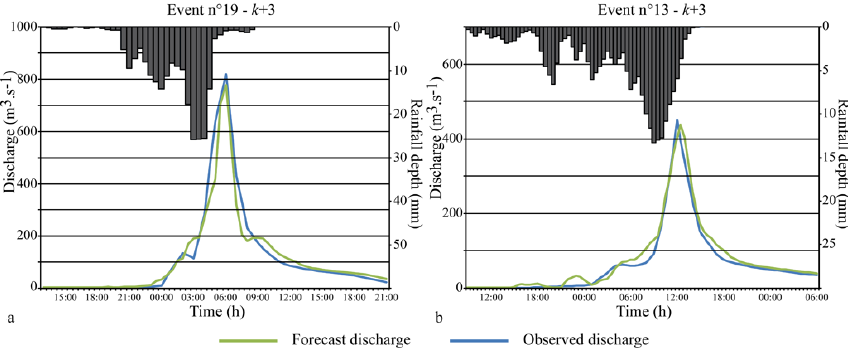
Fig. 8. (a) Predicted and observed hydrographs for the k +3 horizon on event no. 19 using the feedforward model; (b) predicted and observed hydrographs for k + 3 horizon on event no. 13 with the feedforward model.